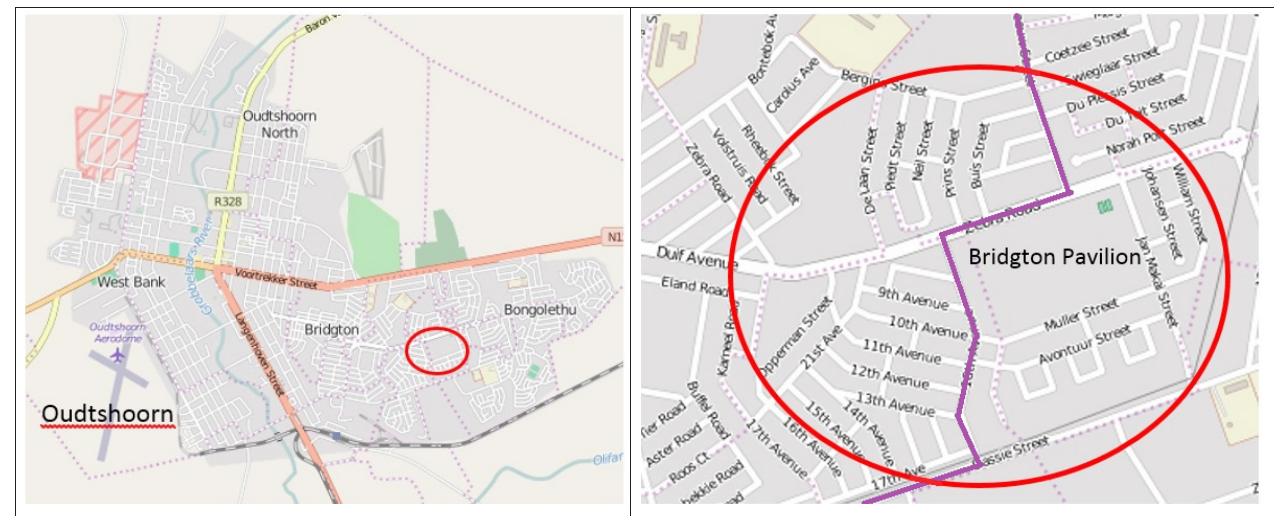
Figure 3: The Bridgton/Bongolethu case study